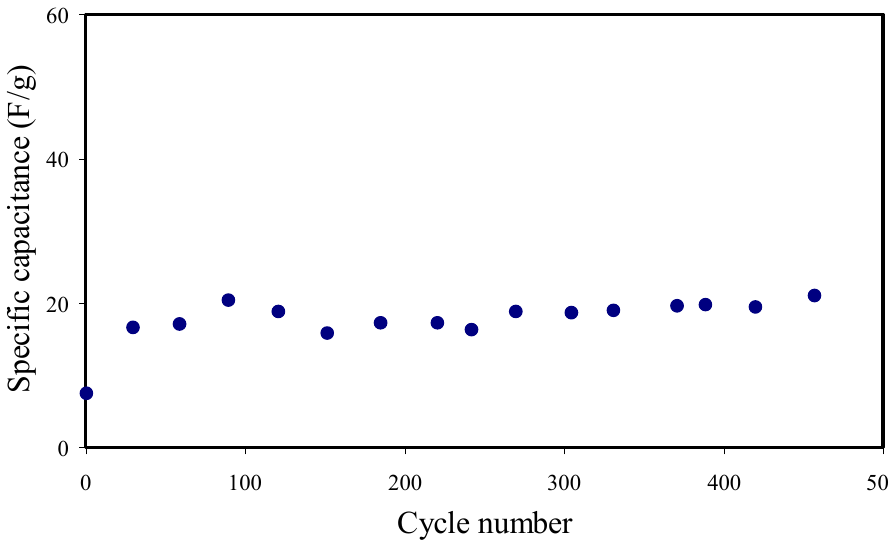
Figure 13. Specific capacitance of the EDLC device for the 450 cycles at RT. The other parameters (power density ( P d ) and energy density ( E d )) are measured using Equations (26) and (27) [3,29]: